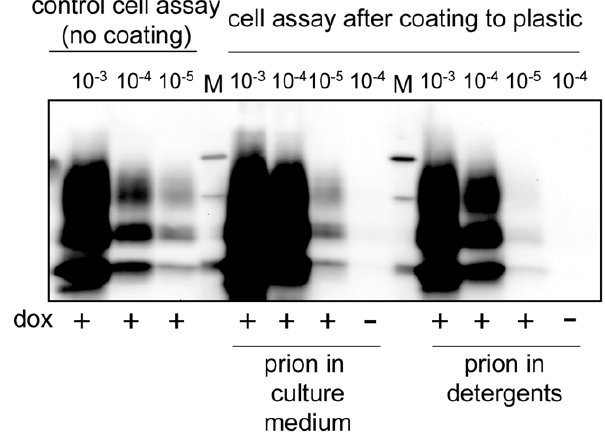
Figure 3. Cell assay detection of plastic-bound prions. Infectivity from 10% PG127 brain homogenate was diluted either in culture medium (prion in culture medium) or in Triton-DOC lysis buffer (prion in detergents) and incubated for 2 h into plastic wells. Samples were removed, wells were thoroughly rinsed and air-dried. OvRK13 cells were then seeded in the presence ( + ) or in the absence ( 2 ) of dox. PrP res in the cultures was analyzed 4 weeks later by immunoblotting and compared to PrP res levels in ovRK13 cultures subjected to the standard cell assay (no coating). M are standard molecular mass marker proteins (20, 30 and 40